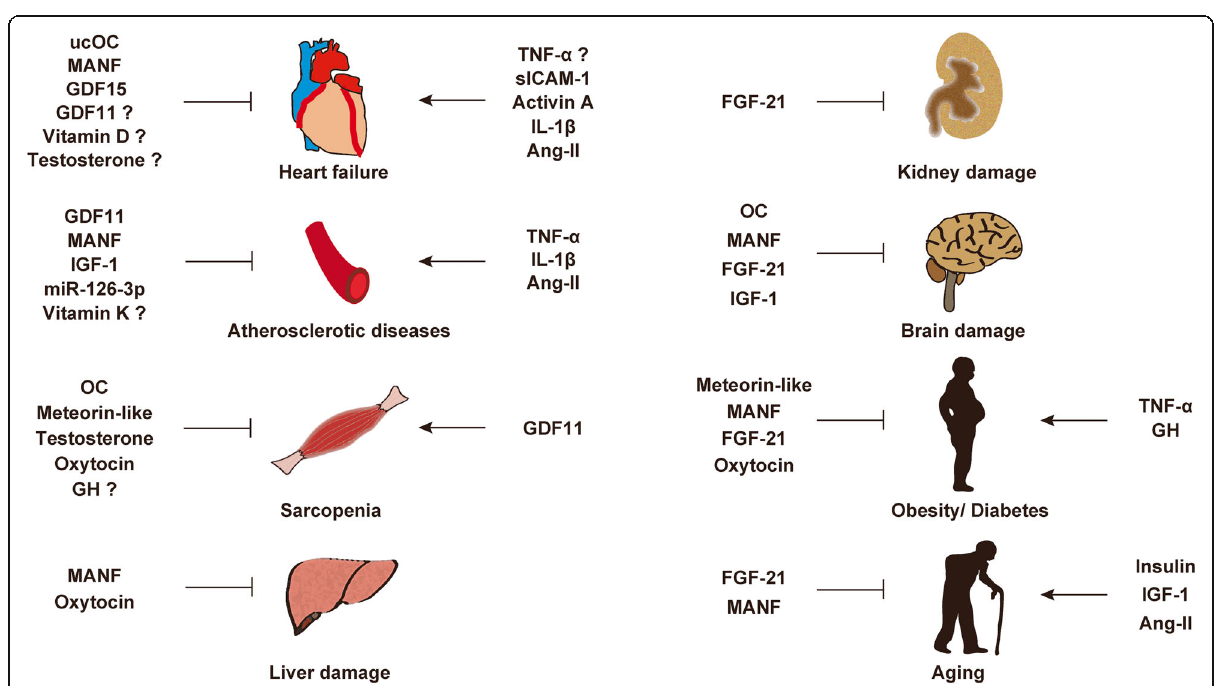
Fig. 2 Circulating molecules characterized to suppress (inhibitory arrow) or enhance (arrow) described conditions. The question mark indicates inconsistent or controversial findings among papers. Undercarboxylated osteocalcin (ucOC), mesencephalic astrocyte-derived neurotrophic factor (MANF), growth differentiation factor (GDF), insulin-like growth factor-1 (IGF-1), osteocalcin (OC), growth hormone (GH), fibroblast growth factor 21 (FGF-21), tumor necrosis factor α (TNF- α ), angiotensin II